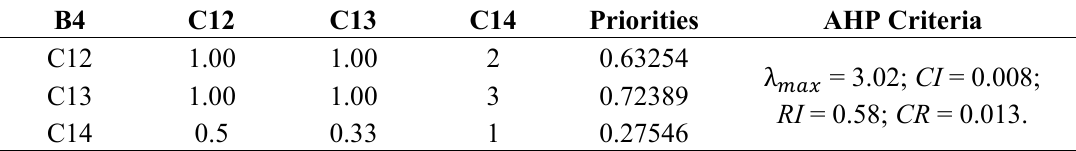
Table 6. Judgment matrix of the criterion B4 and its related